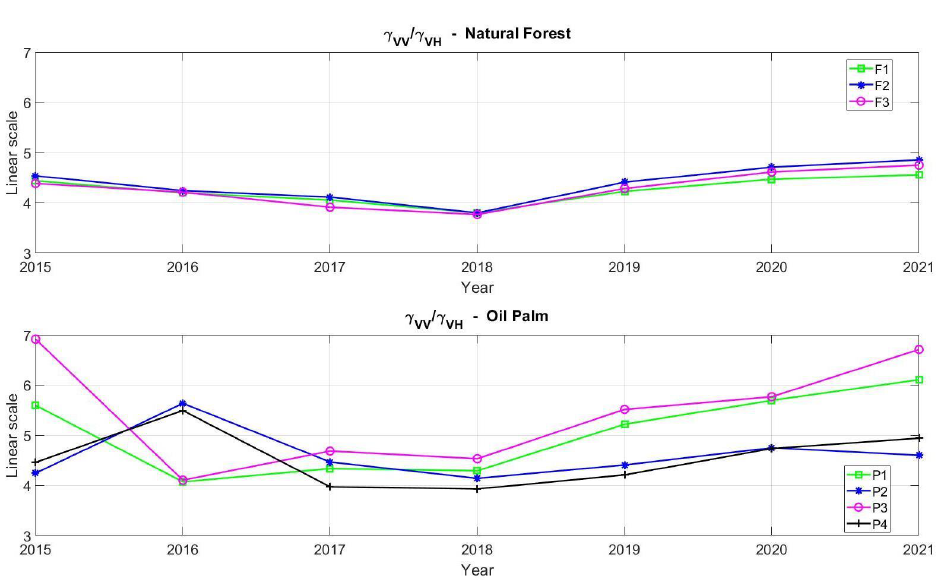
Figure 9. Time series of VV/VH ratio for tropical forest and oil palm plantations during the wet